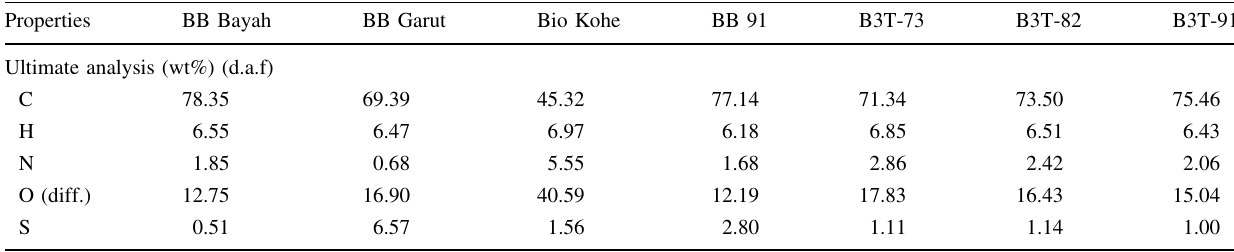
Table 1 Proximate analysis and calorific value of raw coal, biomass waste and bio-coal briquettes Properties BB Bayah BB Garut Proximate analysis (wt%) Total moisture (a.d.b) Volatile matter (d.a.f) Fixed carbon (d.a.f) Ash (d.b) Calorific value (CV) (kcal/kg) (d.a.f)